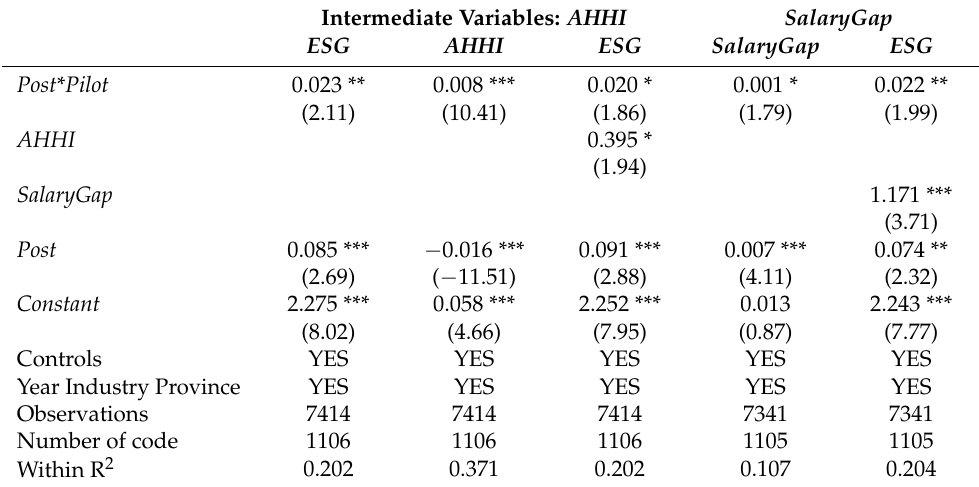
Table 6. Governance mechanism: Subsidy and MSV . Intermediate Variables: